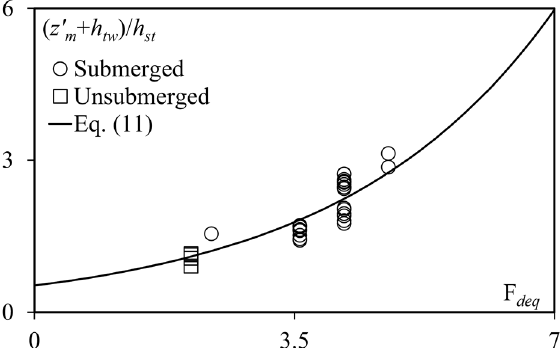
Figure 14. ( z ′ m + h tw )/ h st vs F deq for submerged and unsubmerged chevrons, along with the plot of Equation (11).